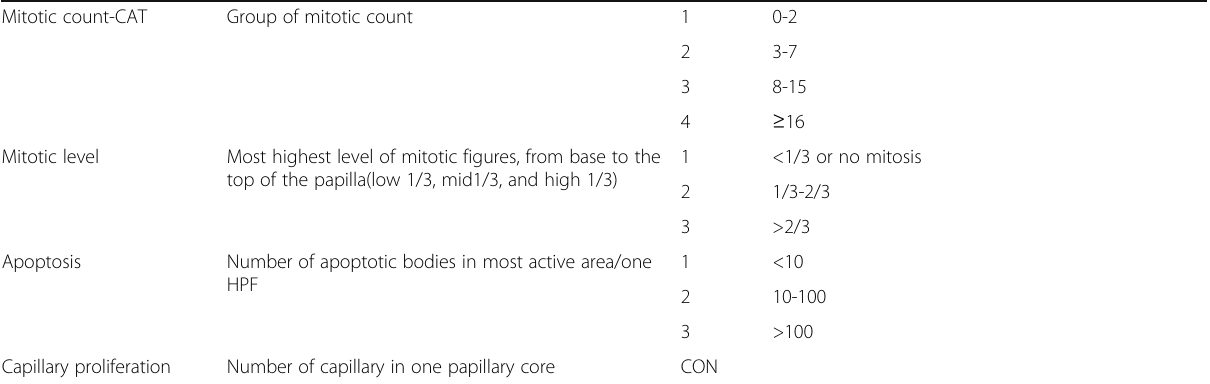
Table 2 Histologic parameters evaluated in this study (Continued) Mitotic count-CAT Group of mitotic